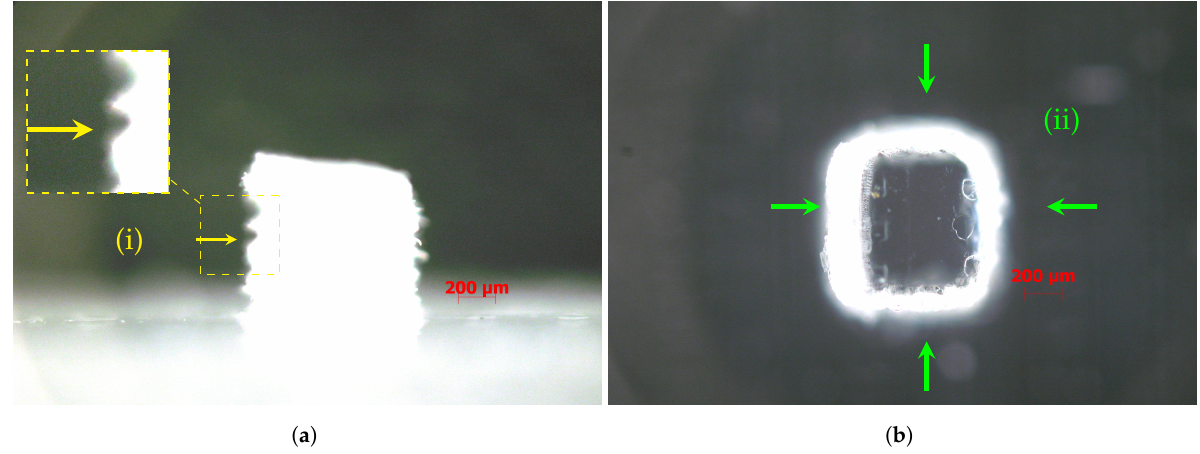
Figure 9. Specimen (S05S) detail: ( a ) side view ( i ) showing the side walls’ roughness and non-uniform surface finish; ( b ) top view ( ii ) showing over-thickness side walls and geometrical distortion. For details about the conditions of the images taken, see Section 2.